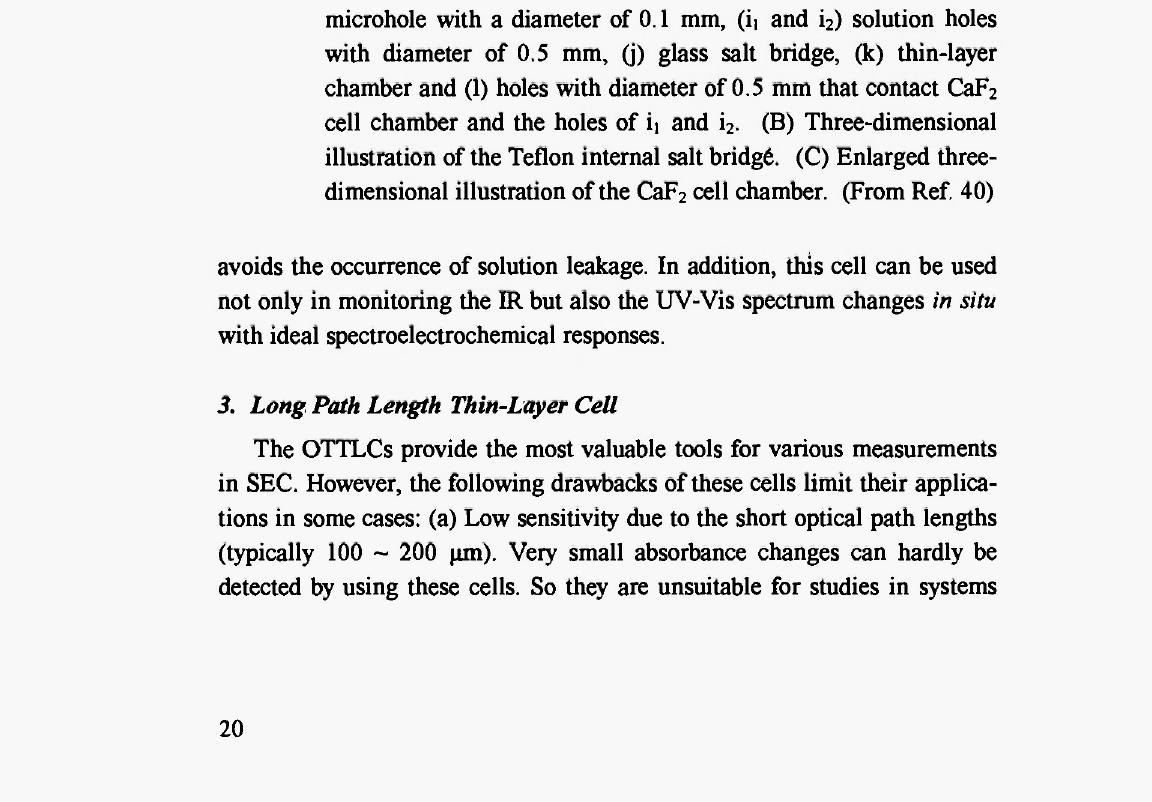
A C Fig. 9: (A) Assembly of the optically transparent ER thin-layer cell: (a) glass bulk solution cell, (b) Teflon internal salt bridge, (c) CaF 2 cell chamber, (d) Teflon thin film, (e) bulge part on glass cell body, (5) metal pedestal, (g) internal reference cavity, (h) microhole with a diameter of 0.1 mm, (ii and i ) solution holes 2 with diameter of 0.5 mm, (j) glass salt bridge, (k) thin-layer chamber and (1) holes with diameter of 0.5 mm that contact CaF 2 cell chamber and the holes of ii and i . (B) Three-dimensional 2 illustration of the Teflon internal salt bridge. (C) Enlarged three- dimensional illustration of the CaF cell chamber. (From Ref. 2